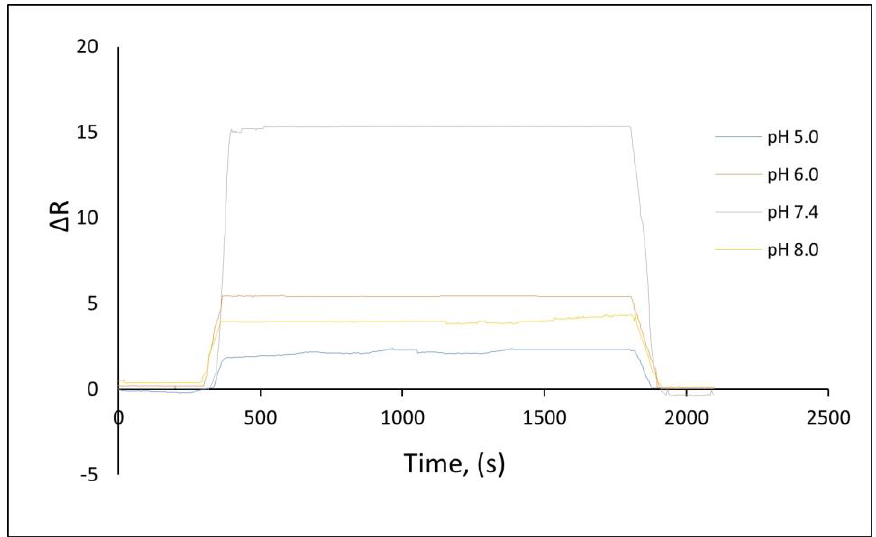
Figure 4. Detection sensorgram of coumaphos by designed CIP-SPR nanosensor in different pH (C: 100 ppb, t: 25 °C).